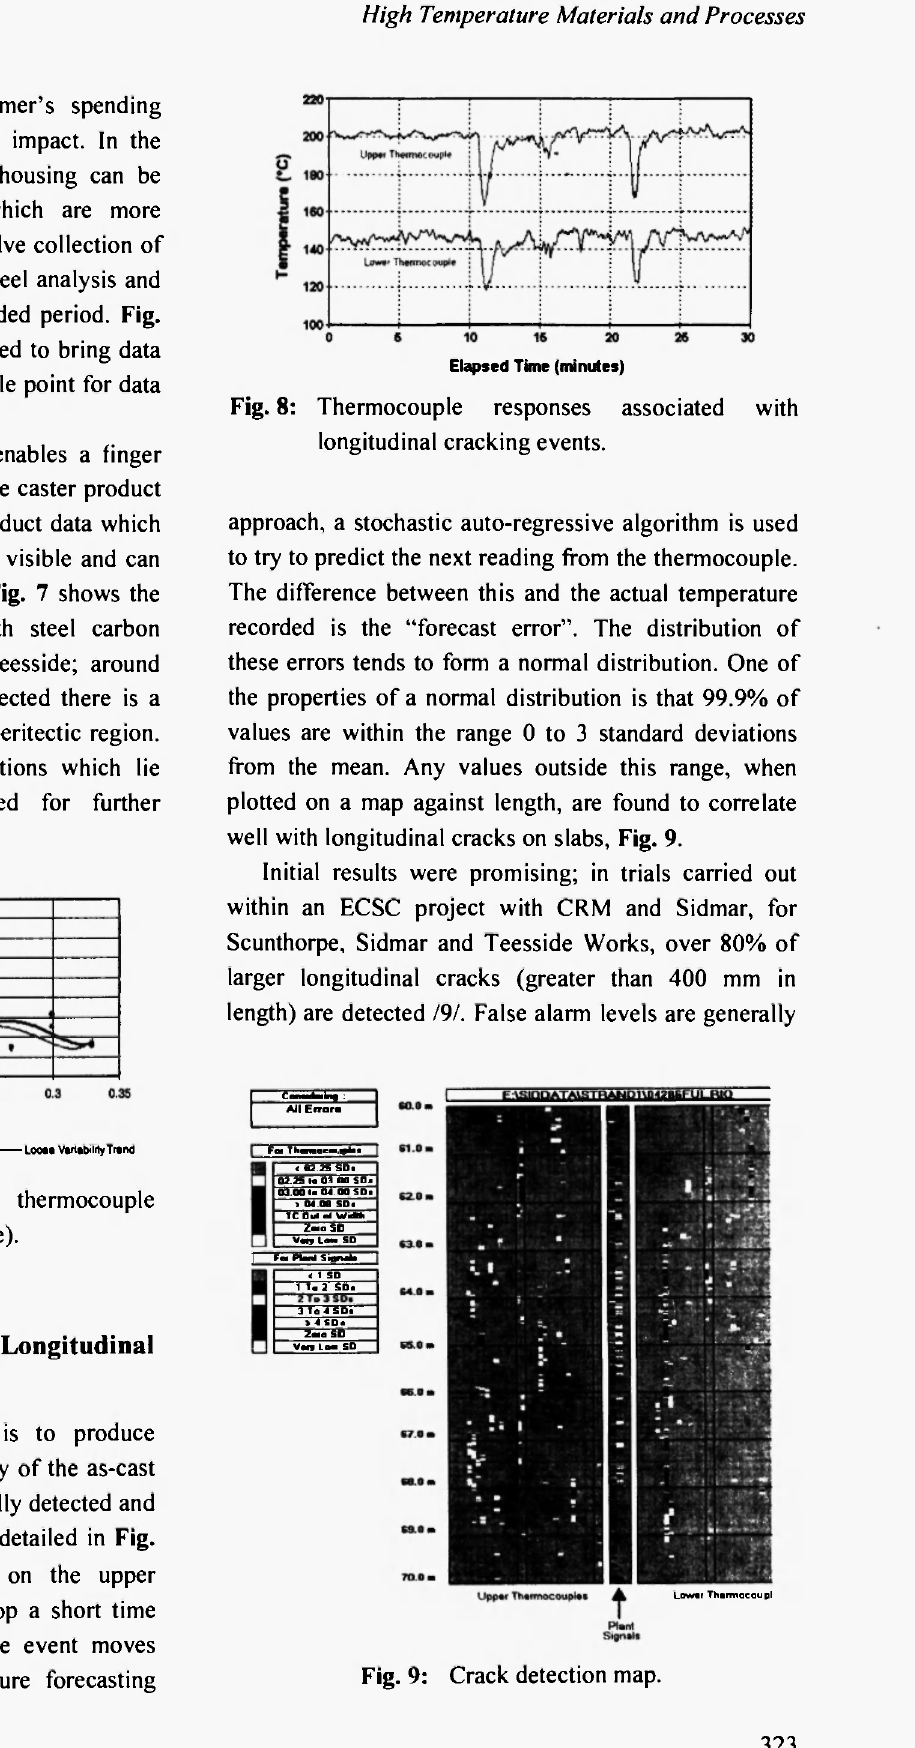
Fig. 9: Crack detection